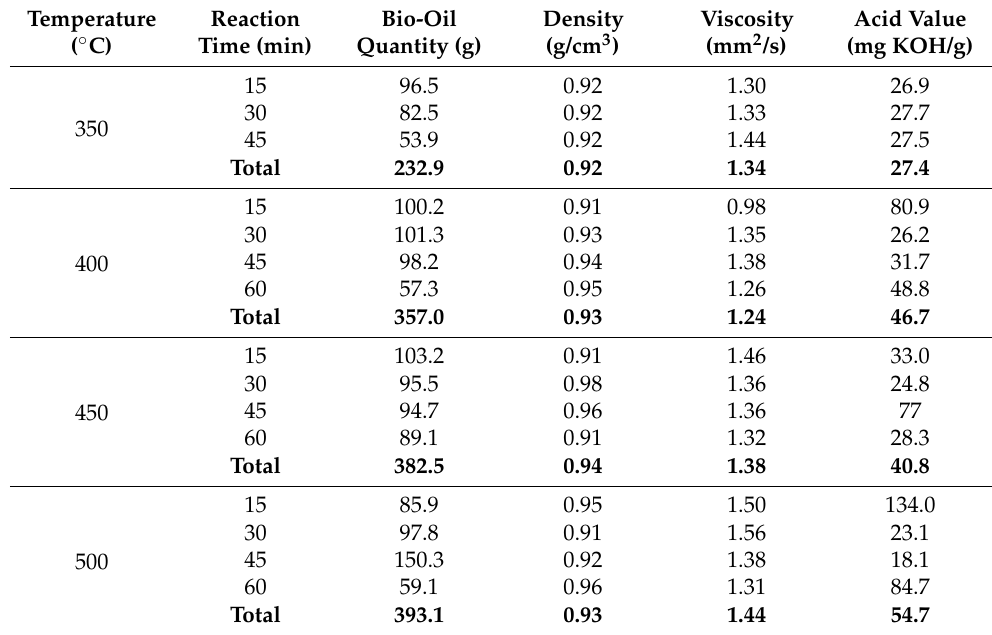
Table 5. Weighted average of determined physical–chemical properties and their respective measured properties of time fractions for thermal experiments. Temperature ( ◦ C)